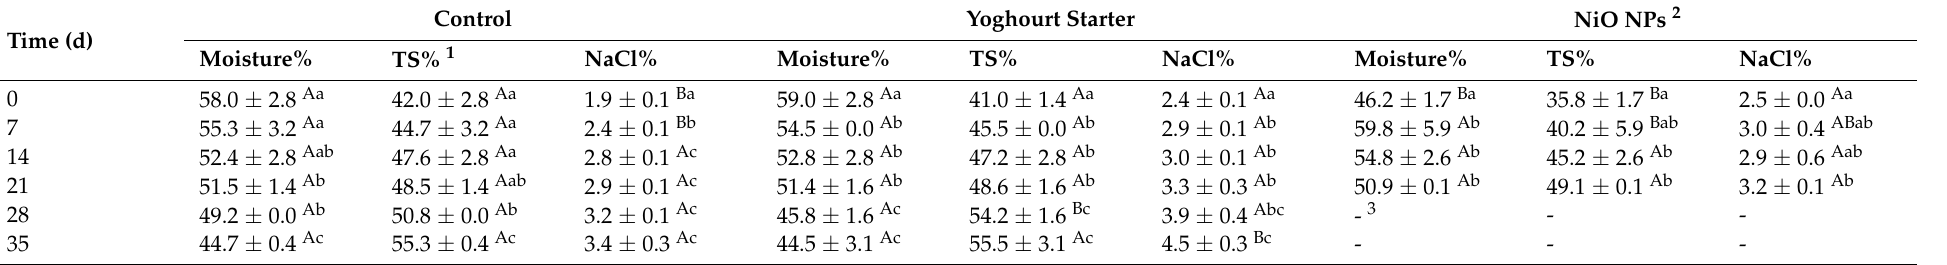
Table 3. Physico-chemical analysis (moisture, total solids & NaCl%) of control, yoghurt starter culture and nickel oxide nanoparticles cheeses during cheese